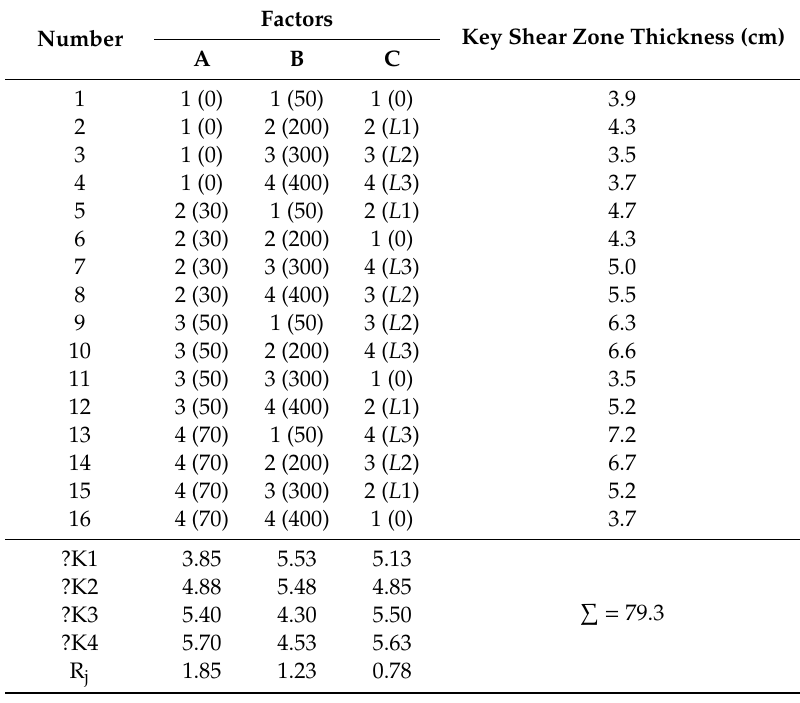
Table 4. Range analysis of the key shear zone